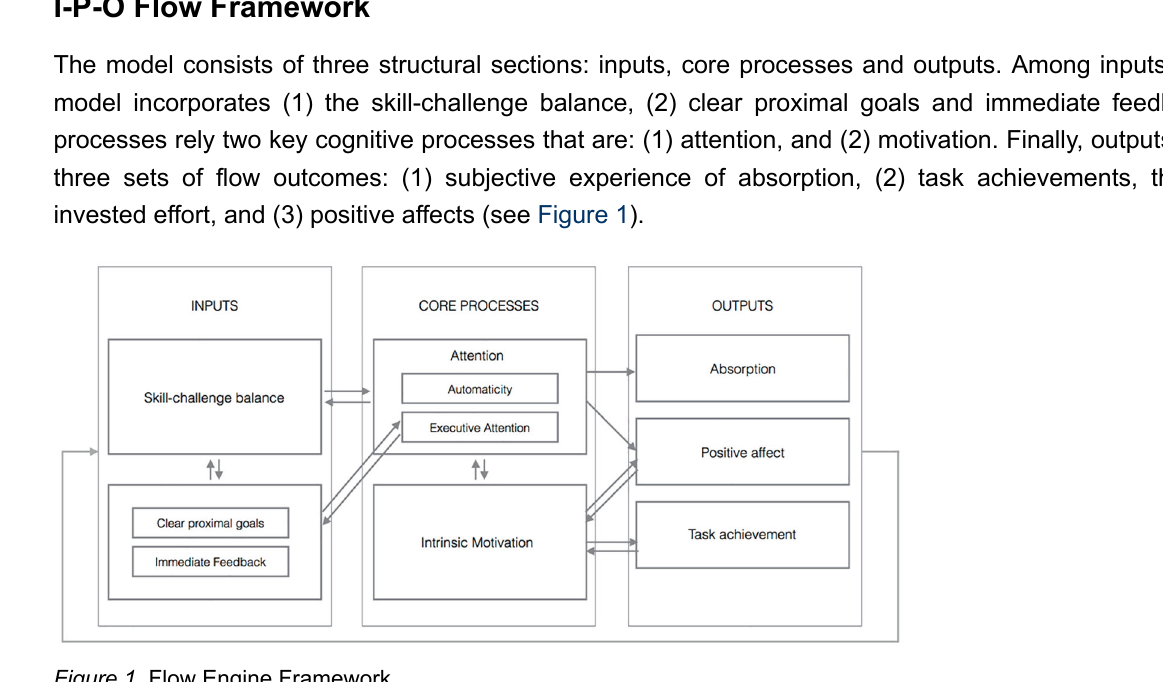
Figure 1. Flow Engine Framework. Note. The simple arrows represent causal relationships between elements. The double arrows represent the loops of